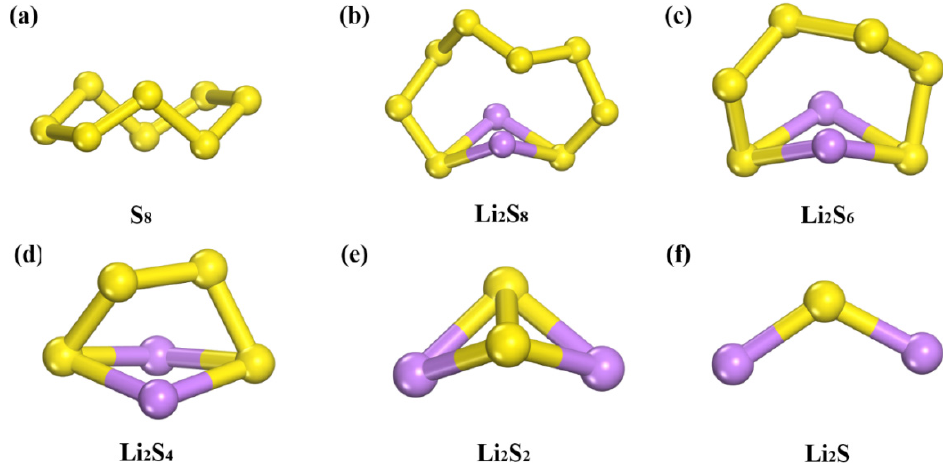
Figure 2. The structures of ( a ) S 8 , ( b ) Li 2 S 8 , ( c ) Li 2 S 6 , ( d ) Li 2 S 4 , ( e ) Li 2 S 2 and ( f ) Li 2 S. Purple balls represent Li atoms. Yellow balls represent S atoms.